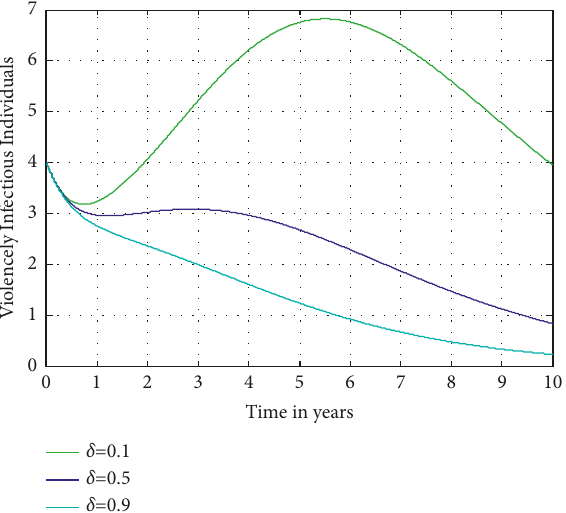
Figure 5: Effect of the reconciled rate δ on the violently infectious individuals. P.